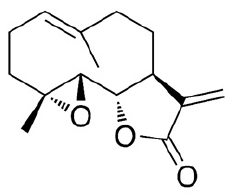
Figure 1. Chemical structure of parthenolide.